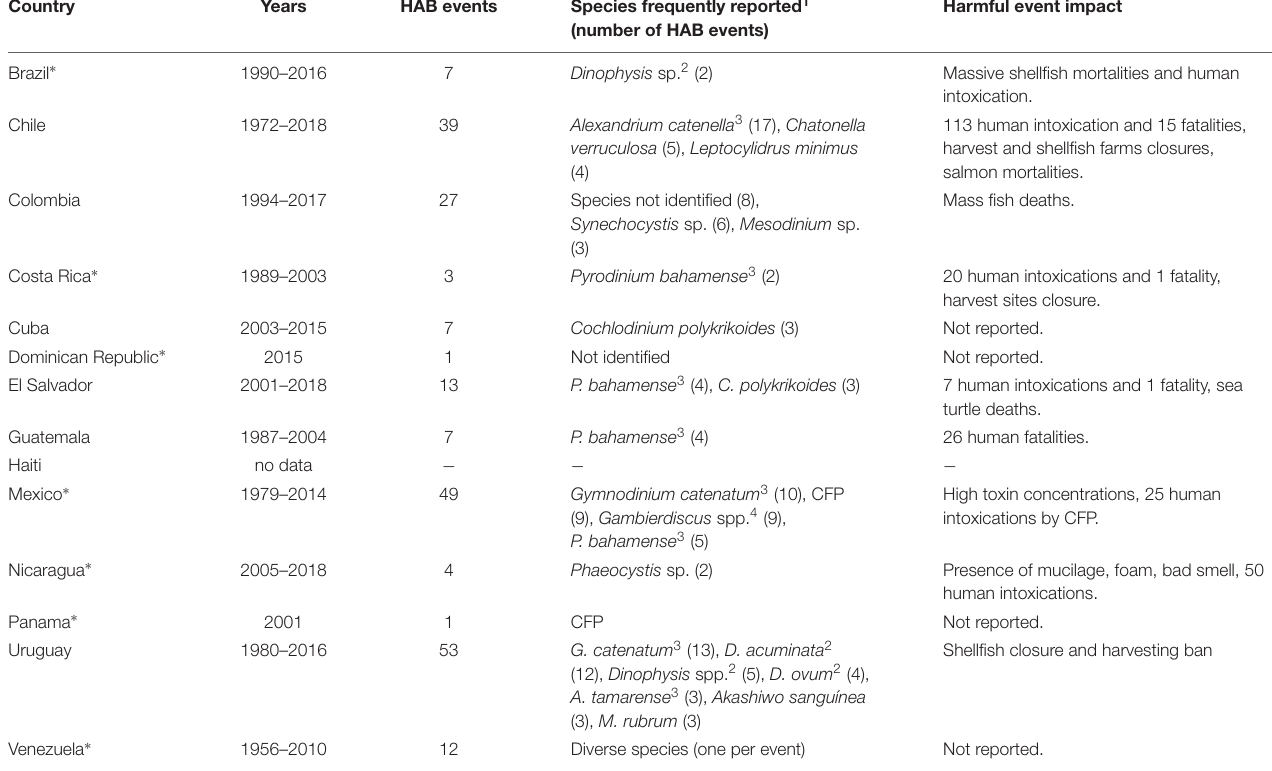
TABLE 1 | HAB records from countries of the Latin America and Caribbean network in the Harmful Algae Event Database (Harmful Algae Event Database [HAEDAT], 2018). Country